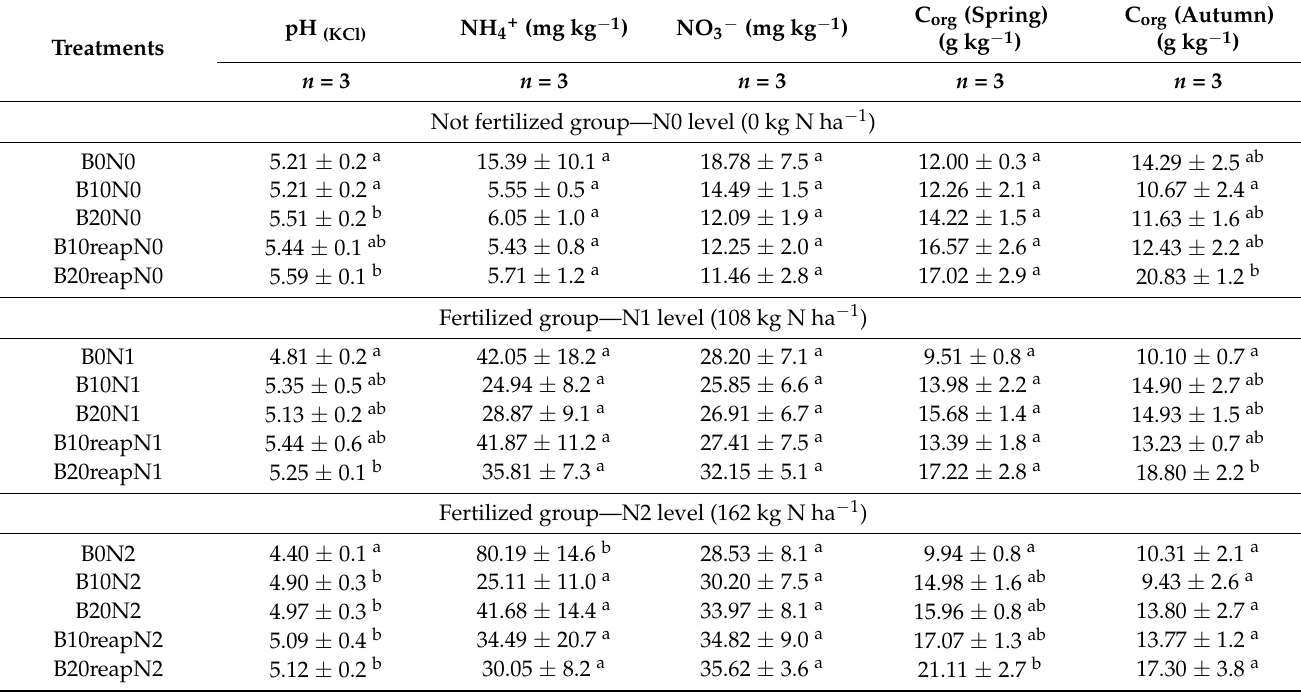
Table 3. Selected chemical properties (soil pH, NH 4+ , NO 3– , SOC) of the soil after different treatments in 2019 (means ± standard errors). Different letters ( a , b ) within columns for each fertilized group indicate that the means are significantly different at p < 0.05 according to the Tukey